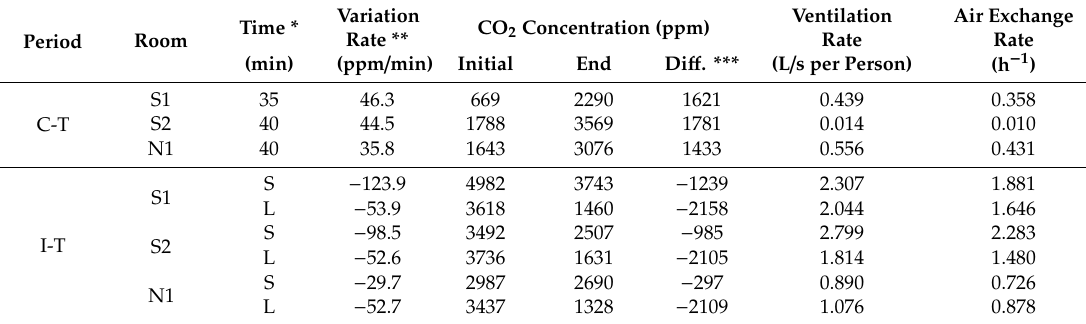
Table 7. The fastest rate of variation in CO 2 concentrations and corresponding